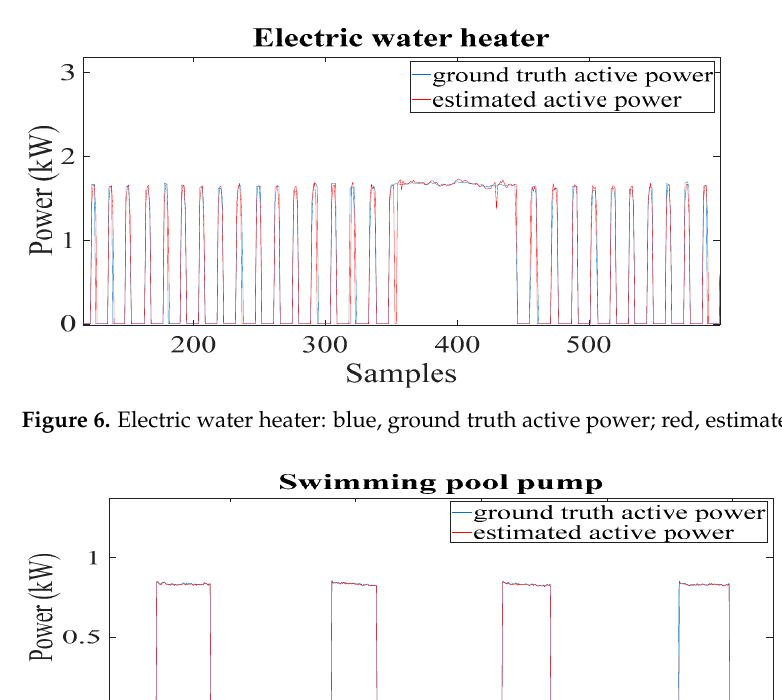
Figure 7. Swimming pool pump: blue, ground truth active power; red, estimated active power.